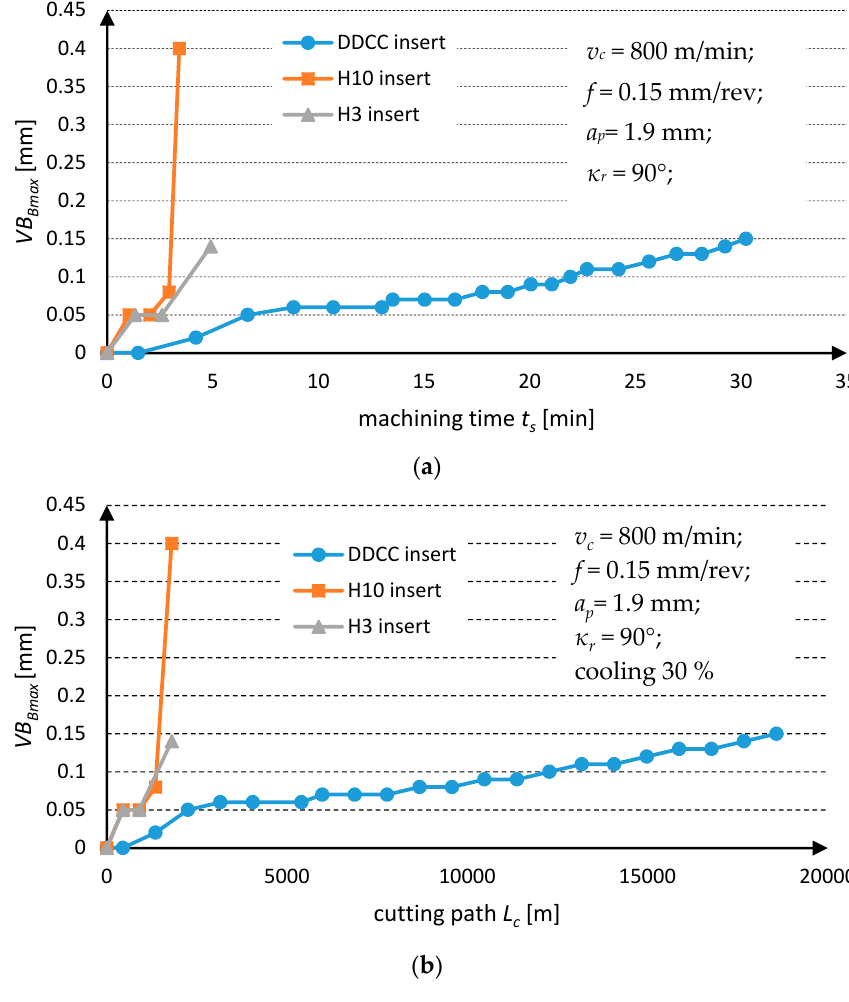
Figure 5. Tool wear curves for DDCC, H3 and H10 inserts obtained during grooving with v c = 800 Figure5. ToolwearcurvesforDDCC,H3andH10insertsobtainedduringgroovingwith v c = 800 m / min m/min and f = 0.15 mm/rev in function of ( a ) cutting time; ( b ) cutting path. and f = 0.15 mm / rev in function of ( a ) cutting time; ( b ) cutting